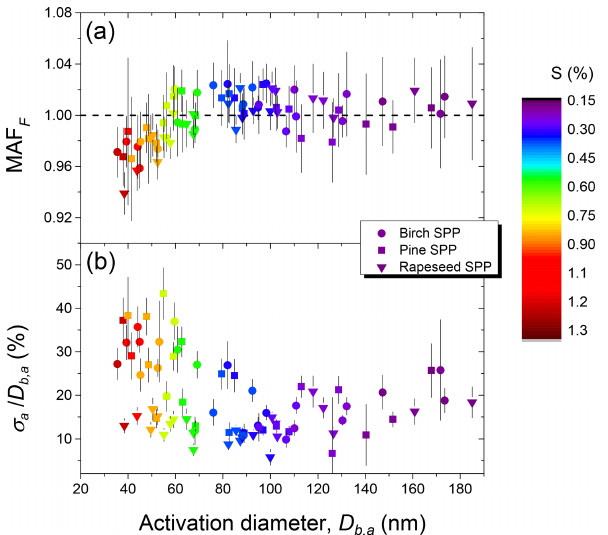
Figure 6. Characteristic parameters of birch, pine, and rapeseed subpollen particles derived from CCN activation curves: maxi- mum activated fraction (MAF F ) (a) and heterogeneity parameter ( σ a /D b,a ) (b) .